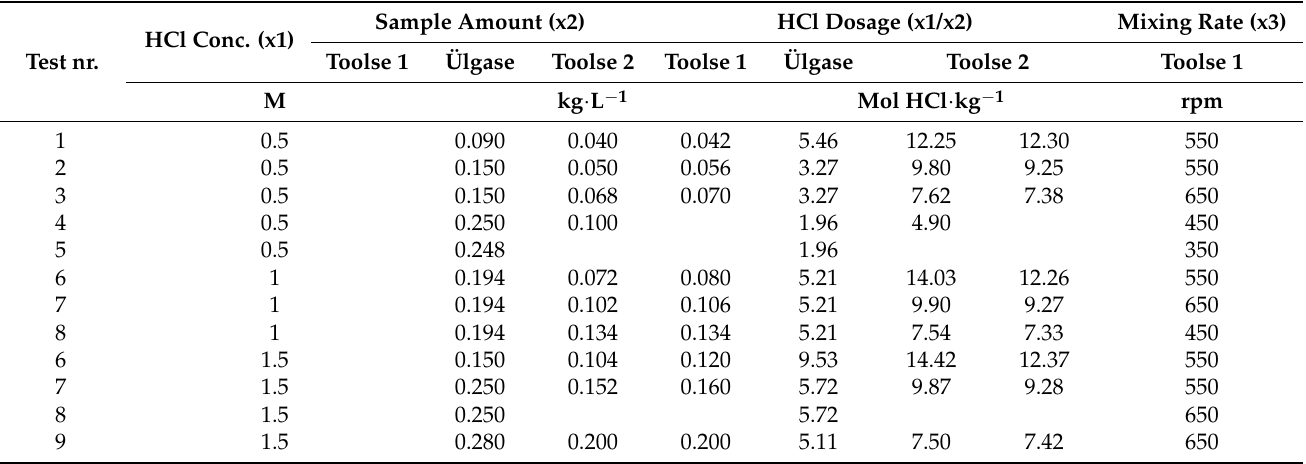
Table 3. Experiments